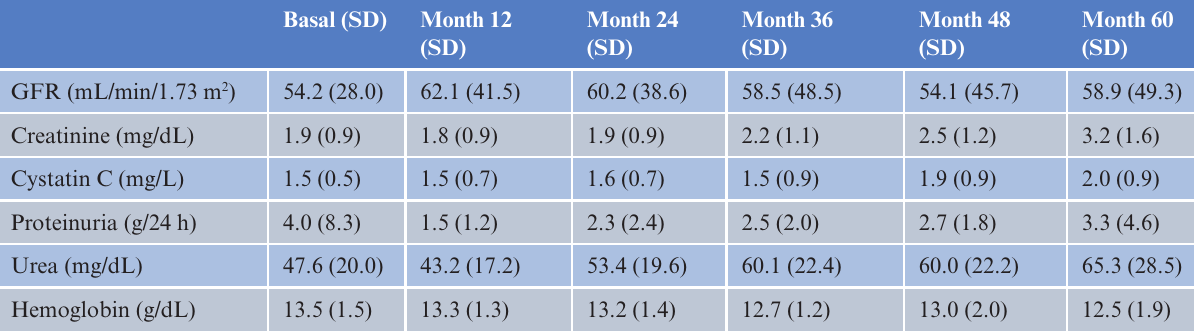
Table 4. PP analysis of average laboratory measurements throughout the